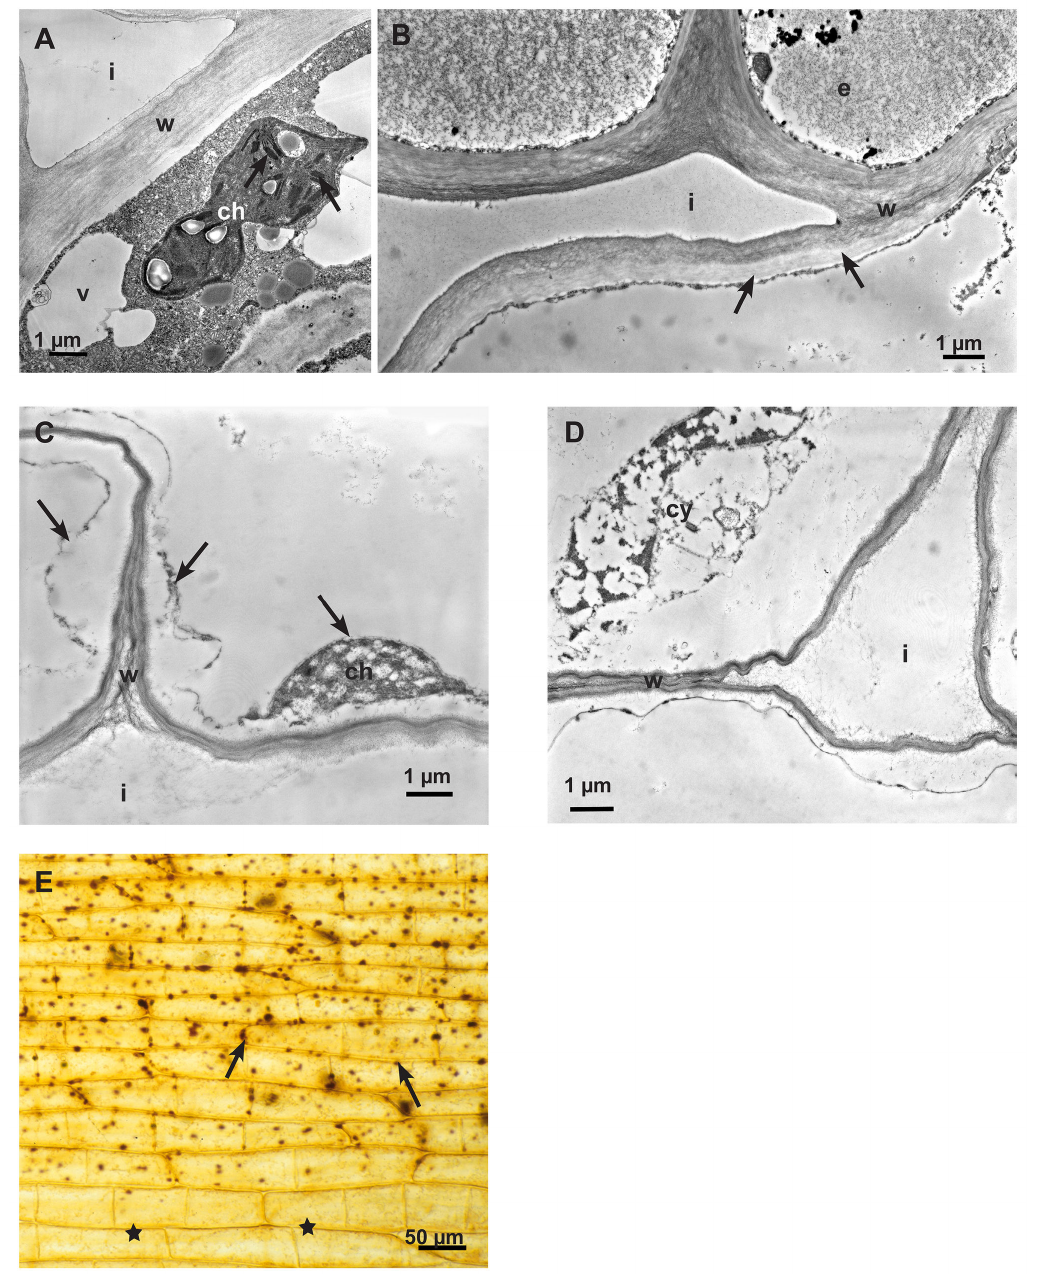
Figure 10. The Effect of oxalic acid on non-infected, living host tissue. Transmission electron micrographs of cross sections of sunflower hypocotyls. A : At a distance from the application of oxalic acid, one of the first effects was on chloroplasts. The intrathylakoid space changed contrast and became electron dense (arrows), chloroplast (ch), intercellular space (i), vacuole (v) and cell wall (w). B : Also in a distance from the application point, the cell walls lost contrast and brightened up from the inner side of the cell (arrows), epidermal cell (e), cell wall (w) and intercellular space (i). C : Detail of cortical parenchyma cells closer to the application point showing more severe effects: Cell walls (w) appeared degraded and the cytoplasm (arrows) severely damaged, residue of a chloroplast (ch) and intracellular space (i). D : Detail of cortical parenchyma cells close to the application point showing increased destruction effects on cytoplasm (cy) and cell walls (w) and intracellular space (i). E : Light micrograph of oxalic acid treated epidermal strip after histochemical staining of calcium oxalate (Method by Yasue). The effect of the oxalic acid becomes visible by brown staining particles (arrows), probably chloroplasts. Tissue without contact to oxalic acid (stars). There was no bleaching effect visible. doi: 10.1371/journal.pone.0072292.g010 PLOS ONE |